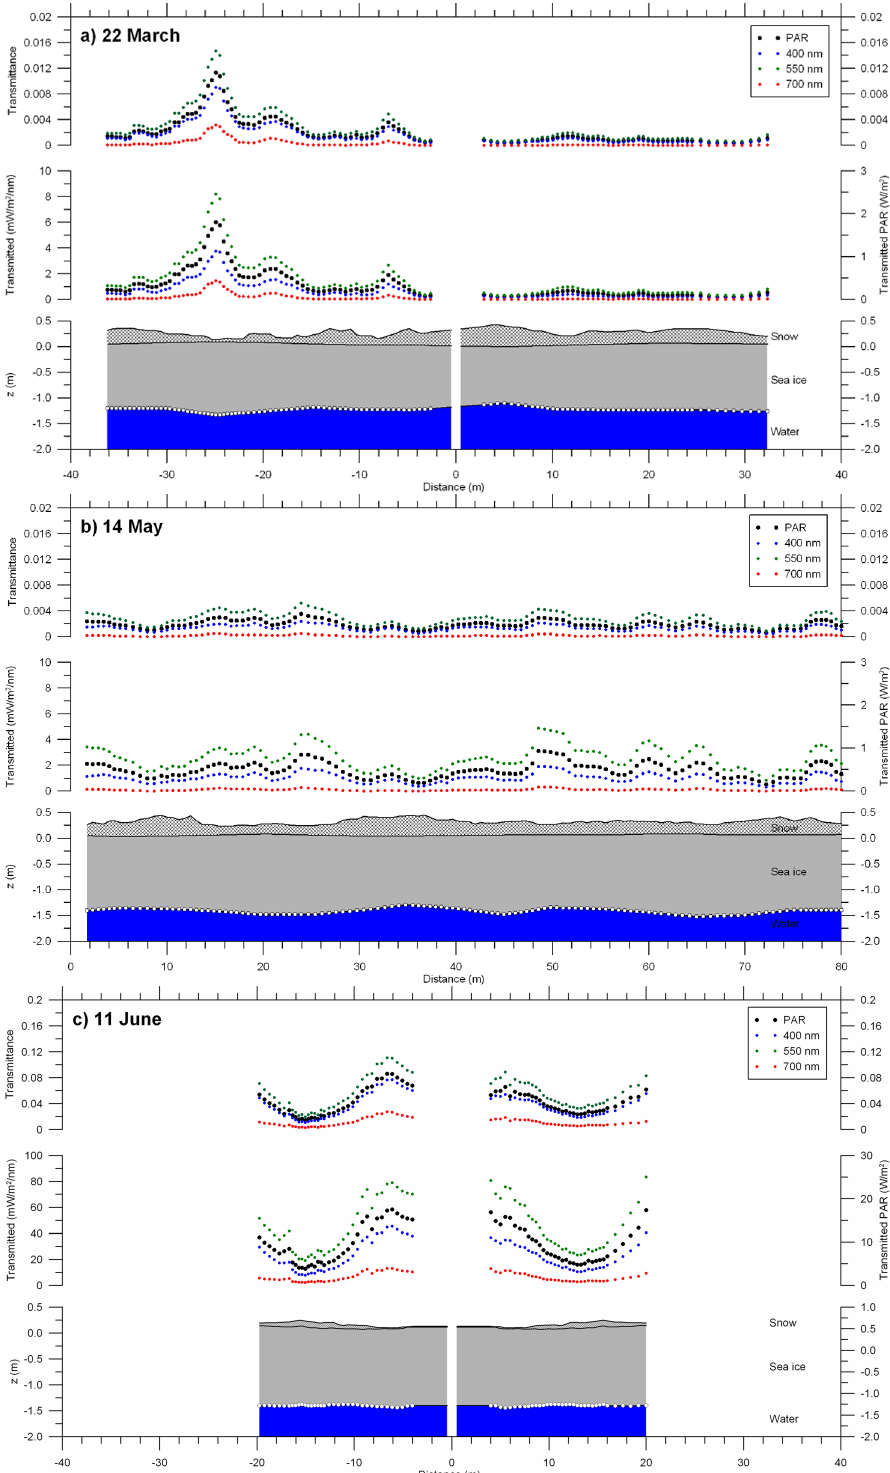
Fig. 3. Transect geometry (bottom), transmitted irradiance (middle), and transmittance (top) of snow and sea ice for each of the three transects in (a) March, (b) May, and (c) June 2010. Radiation data are given for photosynthetically active radiation (PAR, black circles) and spectral values at 400nm (blue dots), 550nm (green dots), and 700nm (red dots). Note different scales (factor 10) on radiation data in June. x = 0 denotes the center of the access hole of the